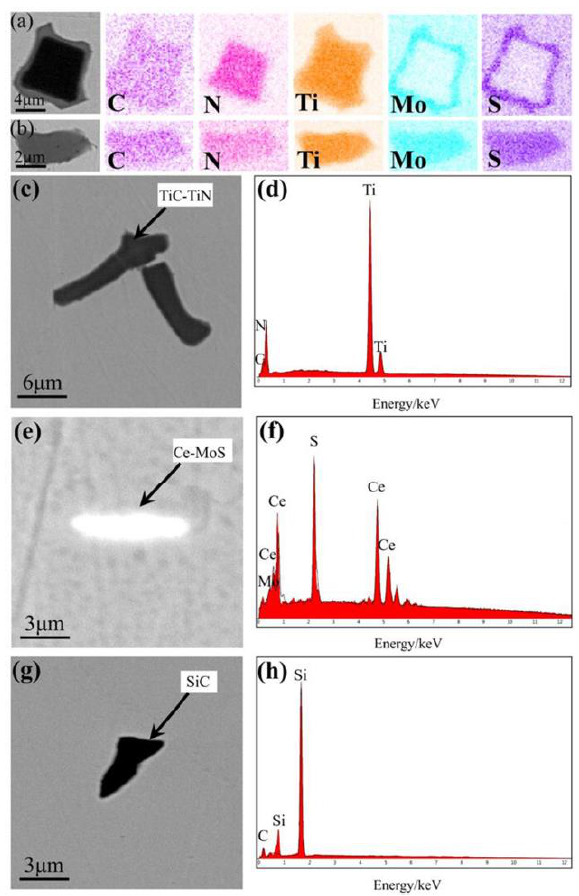
Figure 4. SEM images and energy dispersive spectroscopy (EDS) maps of the primary inclusions in ingot #1: ( a , b ) Ti(C, N) ‐ MoS; ( c , d ) Ti(C, N); ( e , f ) Ce ‐ MoS; and ( g , h ) SiC.